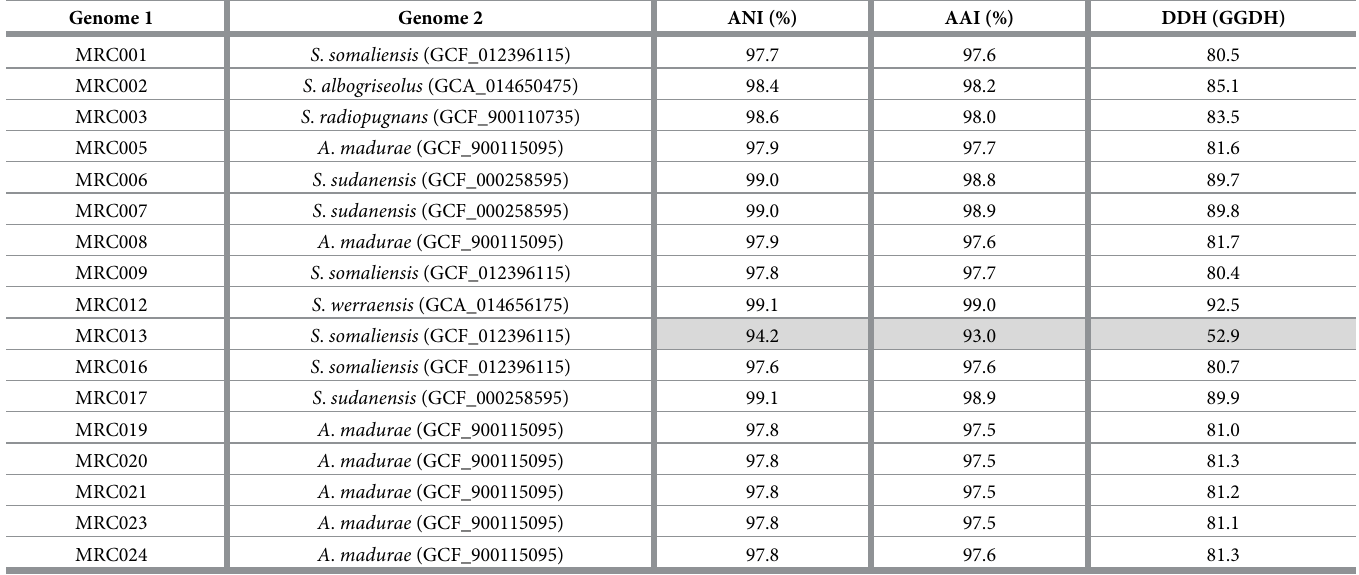
Table 2. Summarising the pairwise ANI, AAI and estimated DDH values between isolates and their nearest relatives with sequenced genomes. S . somaliensis and S . sundanensis type strain genomes are compared to genomes in GTDB. Values that fall below defined thresholds for assigning strains to the same species are highlighted in